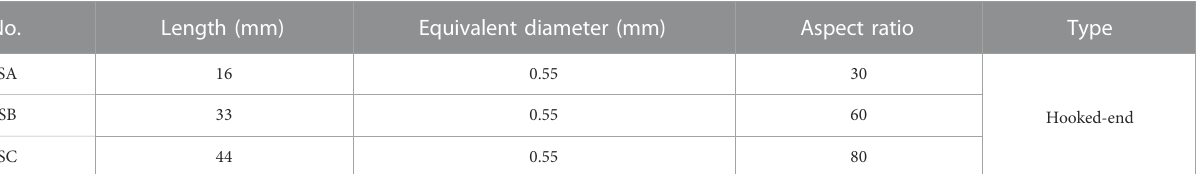
TABLE 1 Physical properties of SF.